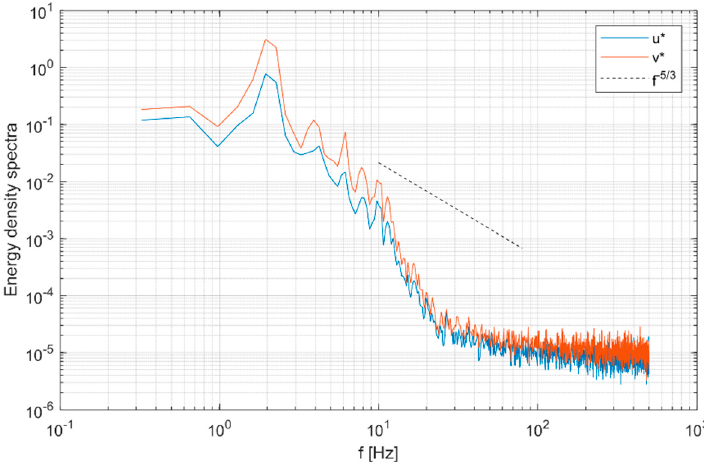
Figure 19. Spectral energy density for coherent fluctuation velocities, u*. Five-thirds law plotted for reference.